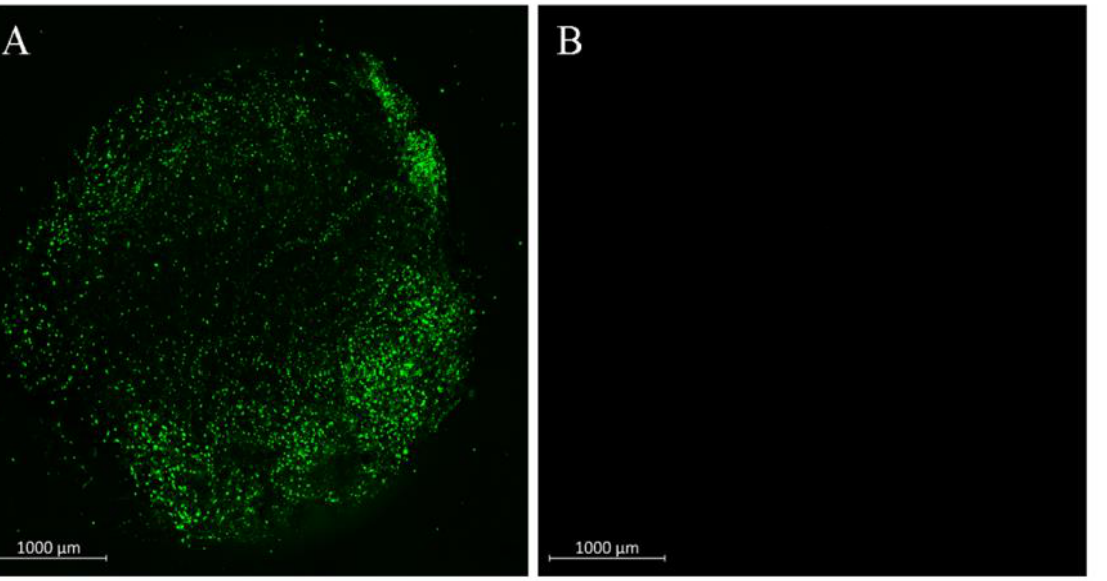
Figure 3. Adenoviral modification of 4 mm muscle/fascia fragments under a laser-scanning confocal microscope. ( A ): Green fluorescent signals were detected in cells residing on the surface of adenovirus-encoding GFP- (Ad.GFP) modified fascia tissue using 4 × 10 8 pfu. ( B ): Green fluorescent signals were absent in non-transduced fascia tissue.